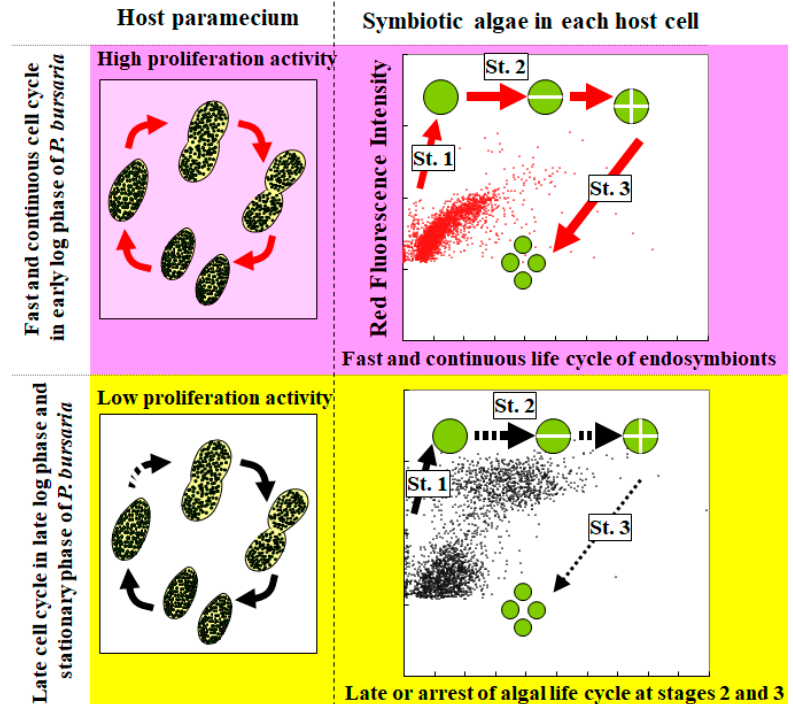
Figure 8. Cooperative dynamics of cell cycle between endosymbiotic algae and their host Paramecium . When the host cells are at the logarithmic growth phase and have high proliferation activity, endosymbiotic algae divide instantly. Then the smooth transition of endosymbionts occurs from algae at the growth and division phases to daughter algae (upper panels) (designated solid arrows). In contrast, endosymbiotic algae divide at a crawl when the host cells are at the early stationary phase and have low proliferation activity. Subsequently, a slow transition of endosymbionts occurs from algae at the division phase to daughter algae (lower panels) (indicated by dotted arrows).